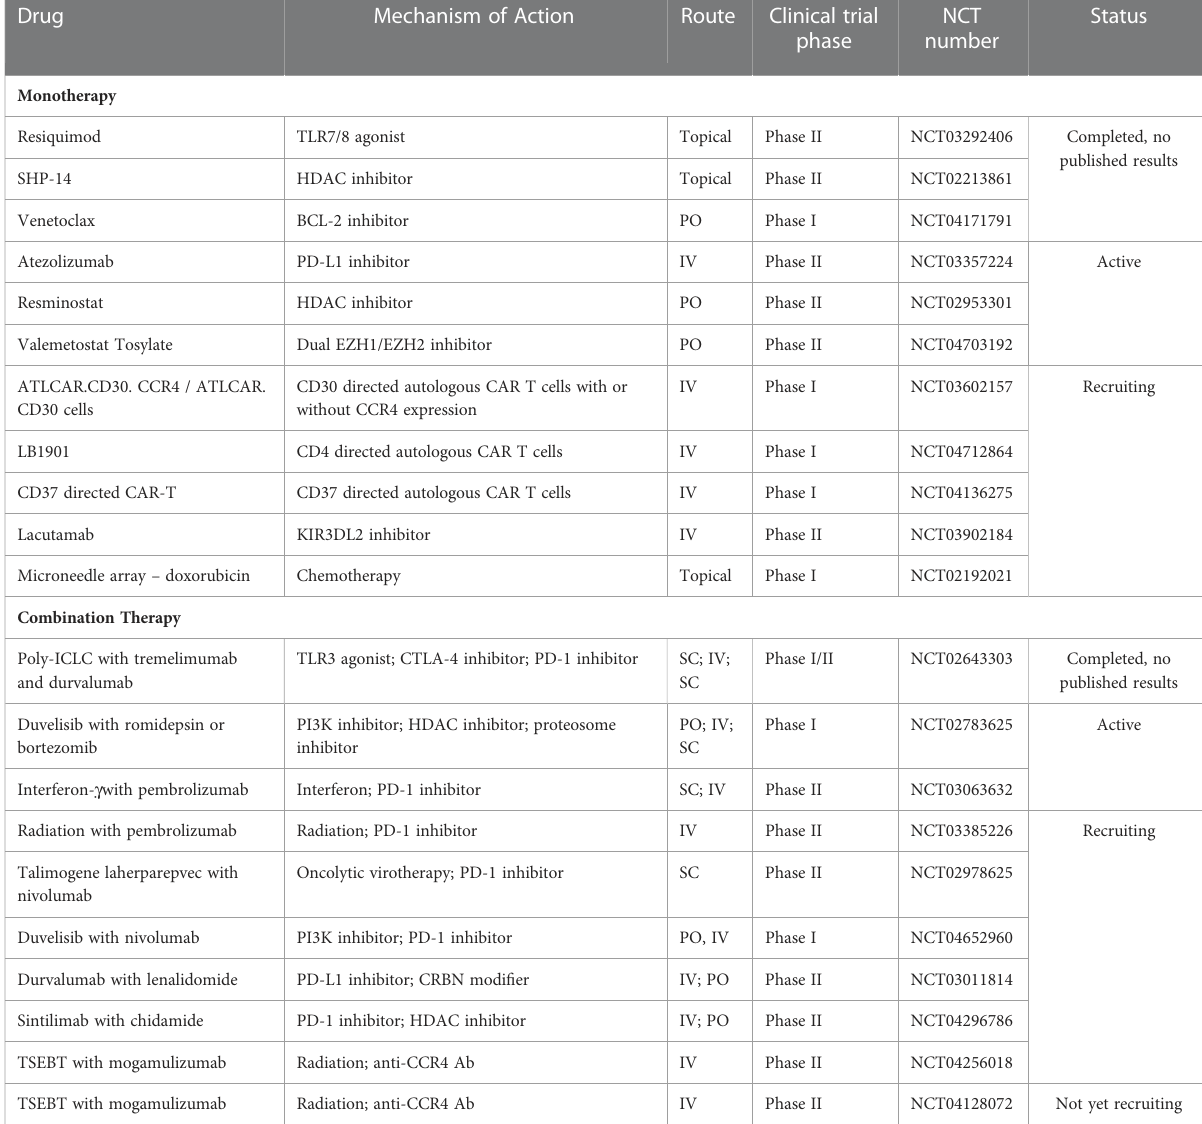
TABLE 5 Therapies under investigation for the treatment of CTCL.